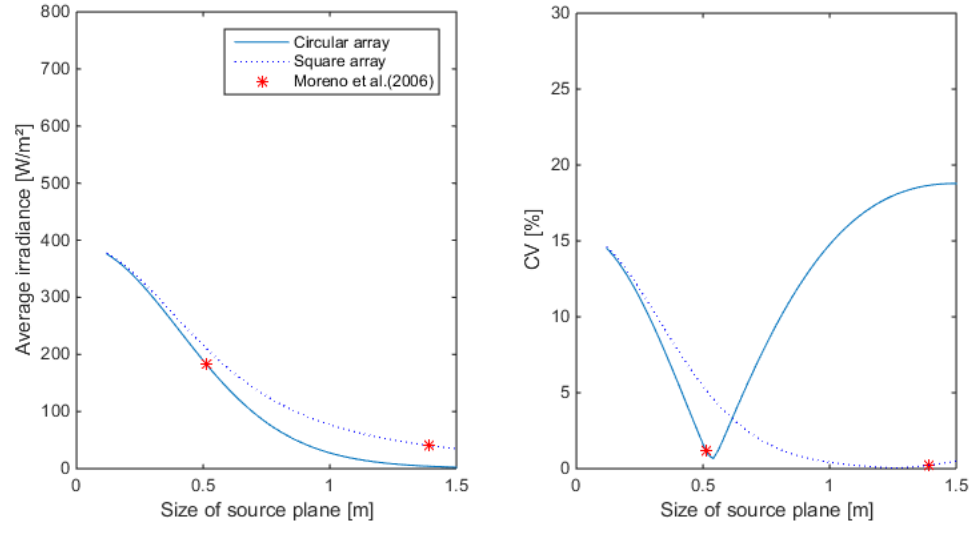
Figure 9. Average irradiance and CV as a function of the source plane size for square and circular arrays of 36 LEDs. Simulations are done with the wide beam lens. ( Left ): Average irradiance; ( Right ):